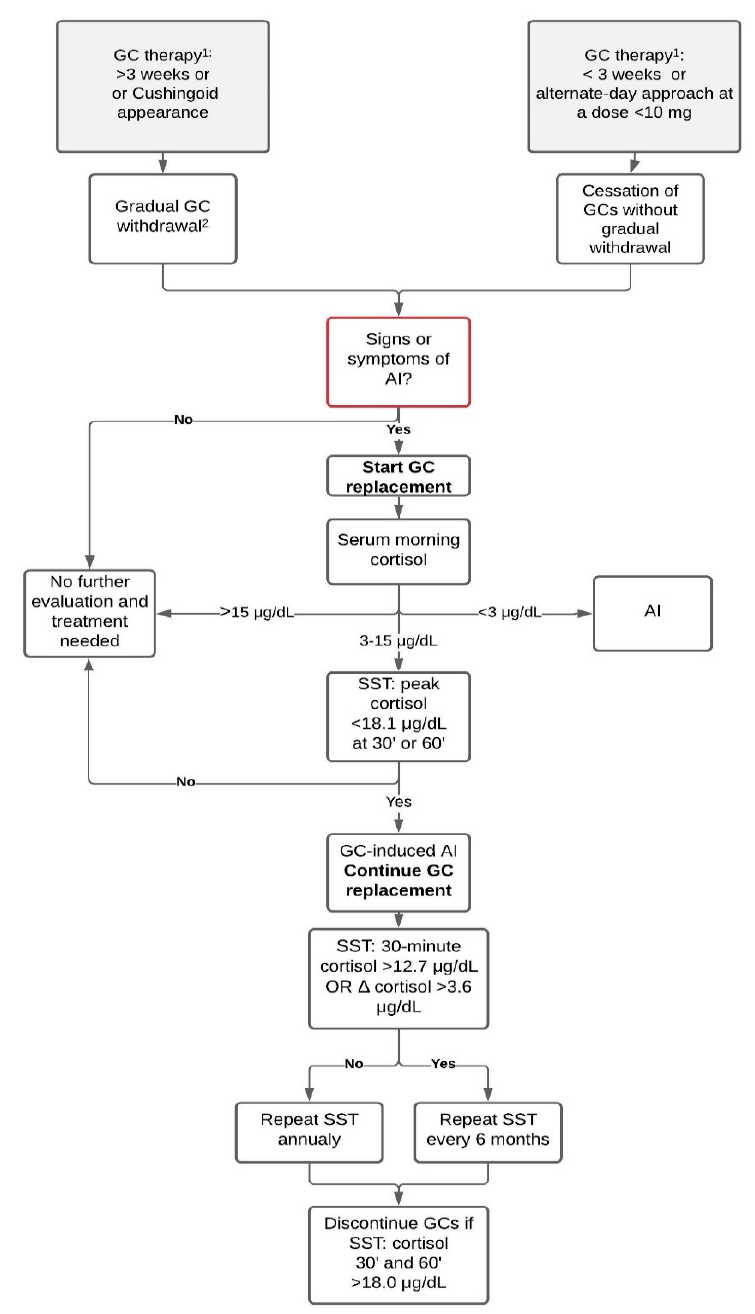
Figure 1. Diagnostic algorithm for patients before and after glucocorticoid withdrawal. Diagnostic workup should never postpone the start of GC replacement treatment when suspecting adrenal crisis. Data from: Furst et al. Glucocorticoid withdrawal. UpToDate. Accessed on 29 March 2021; Fleseriu et al. Hormonal replacement in hypopituitarism in adults: an Endocrine Society Clinical Practice Guideline (2016); Pofi et al. The short synacthen (corticotropin) test can be used to predict recovery of hypothalamo–pituitary–adrenal axis function (2018). Abbreviations: AI, adrenal insufficiency; GC, glucocorticoid; SST, short stimulation test with synthetic ACTH; 1 prednisone or equivalent; 2 as described in the GC withdrawal paragraph. ∆ cortisol: 30-min cortisol minus basal cortisol;